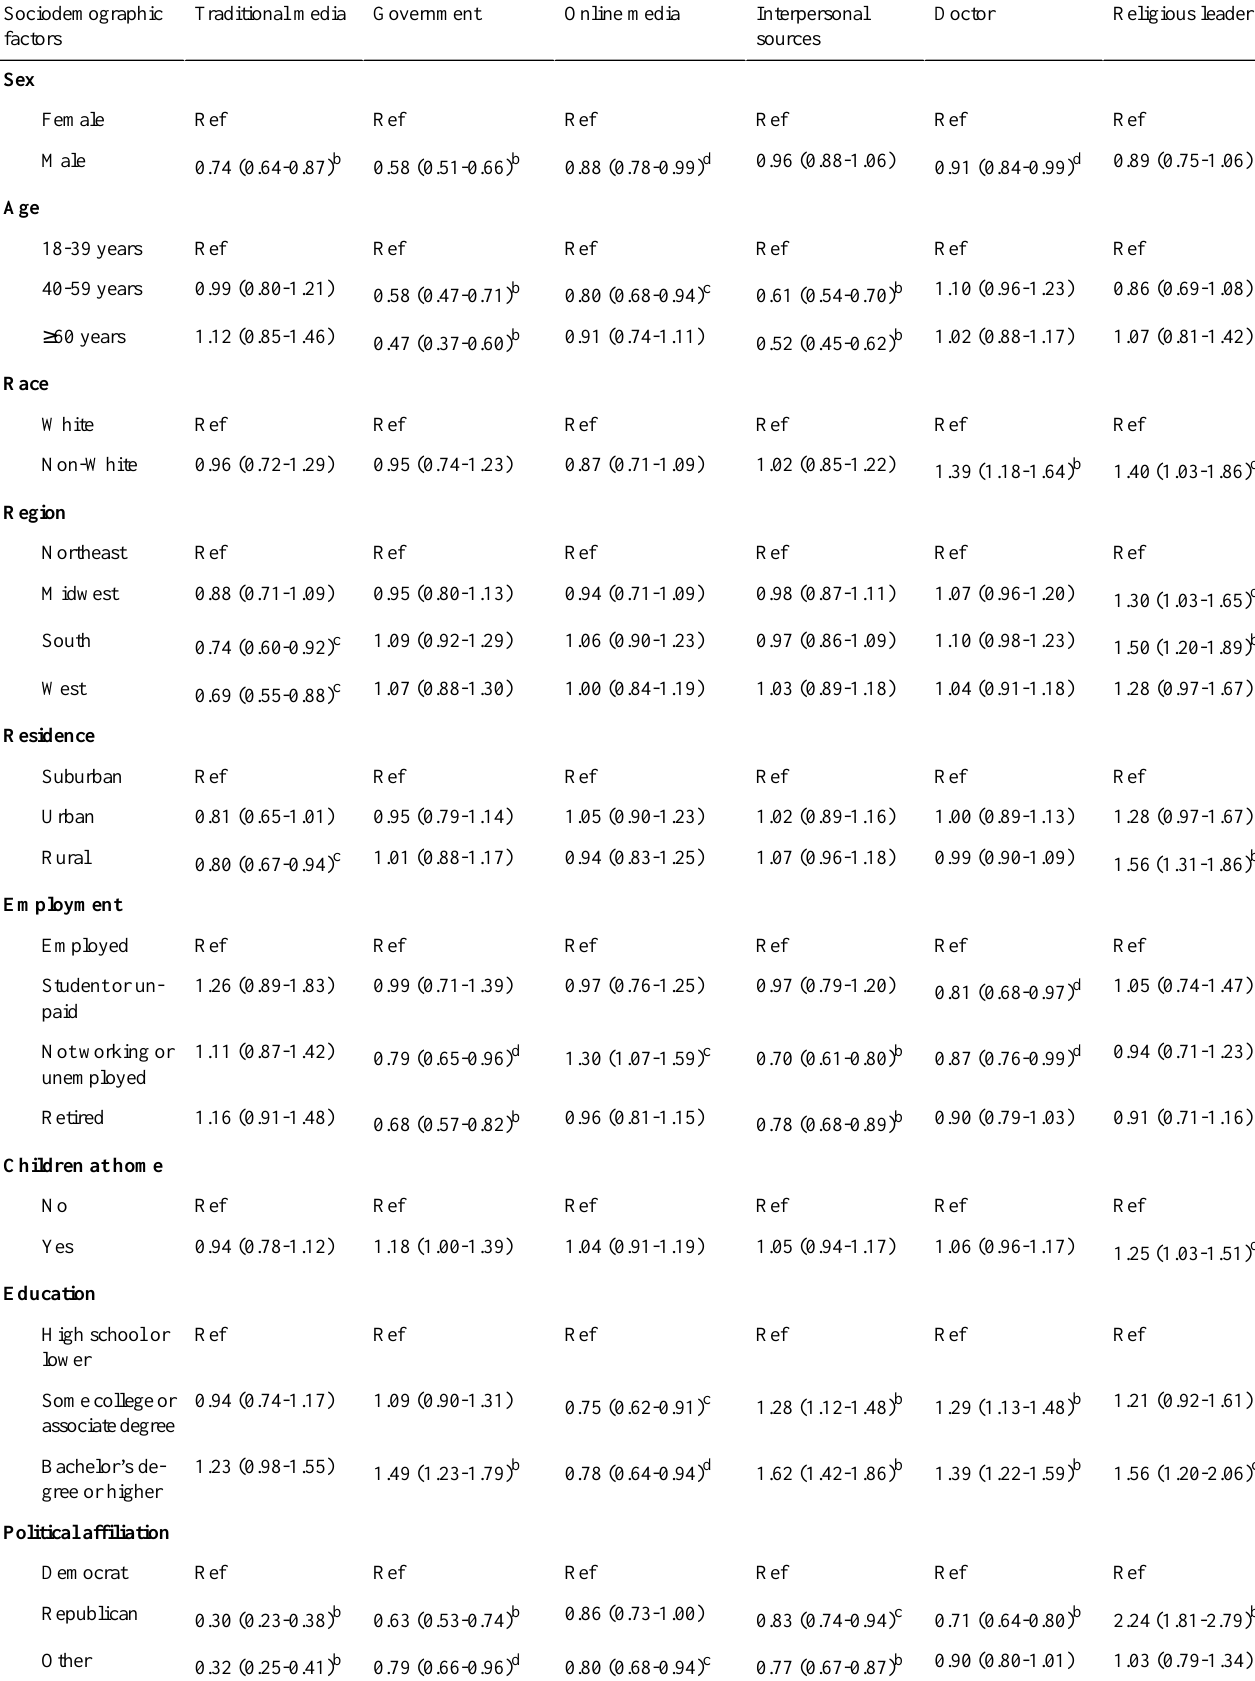
Table 2. Adjusted odds ratios (95% CI) of sociodemographic factors associated with COVID-19 information source (N=11,242) a . Ref: Reference